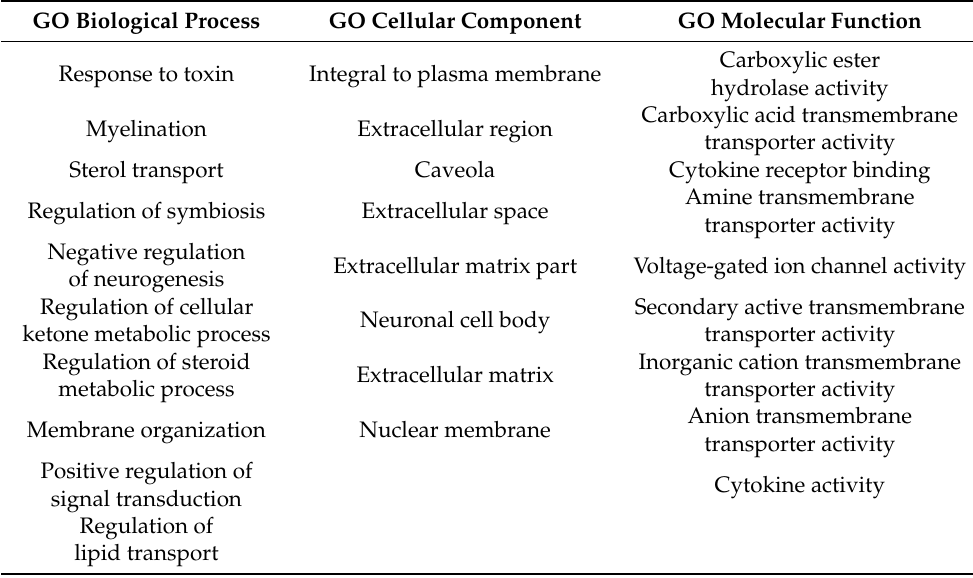
Table 11. Top 10 GO biological processes, cellular components, and molecular functions enriched from differentially expressed genes that are downregulated in MMC spinal cords compared to vehicle at E17. All GO pathways were >1.5-fold and p <